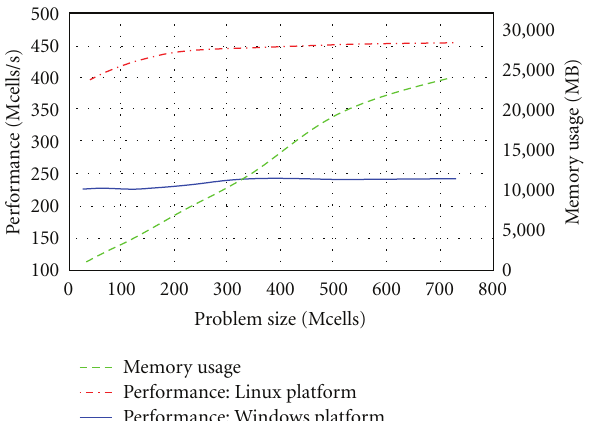
Figure 7: Performance of parallel FDTD enhanced by using SSE instruction set on a 2-CPU workstation platform for the di ff erent operating systems.